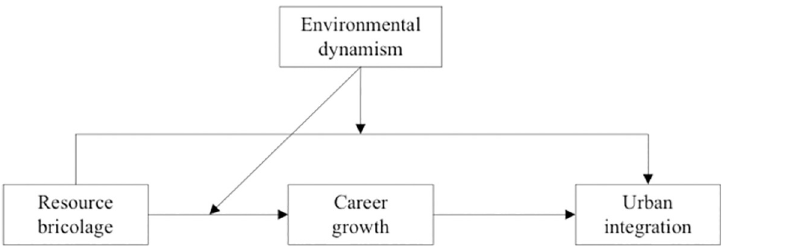
Fig 1. Theoretical model of the mechanisms of resource bricolage on urban